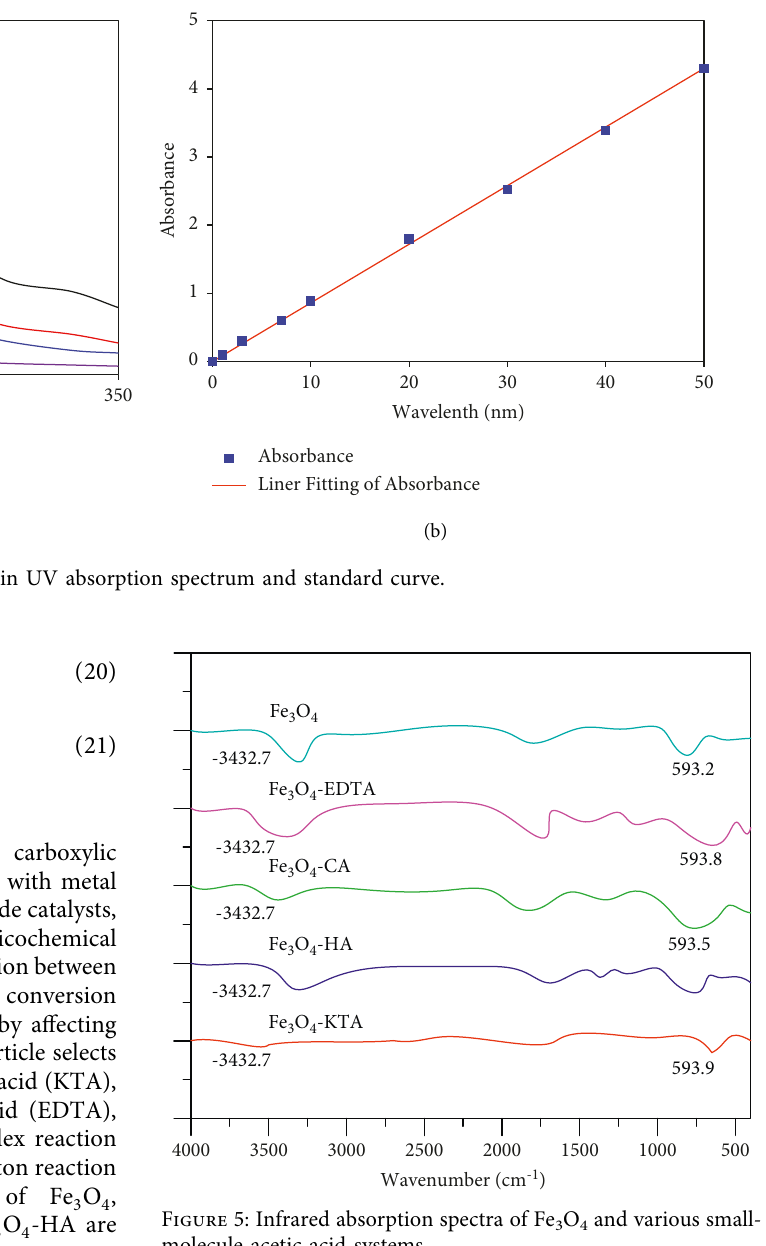
3 O 4 and various small-